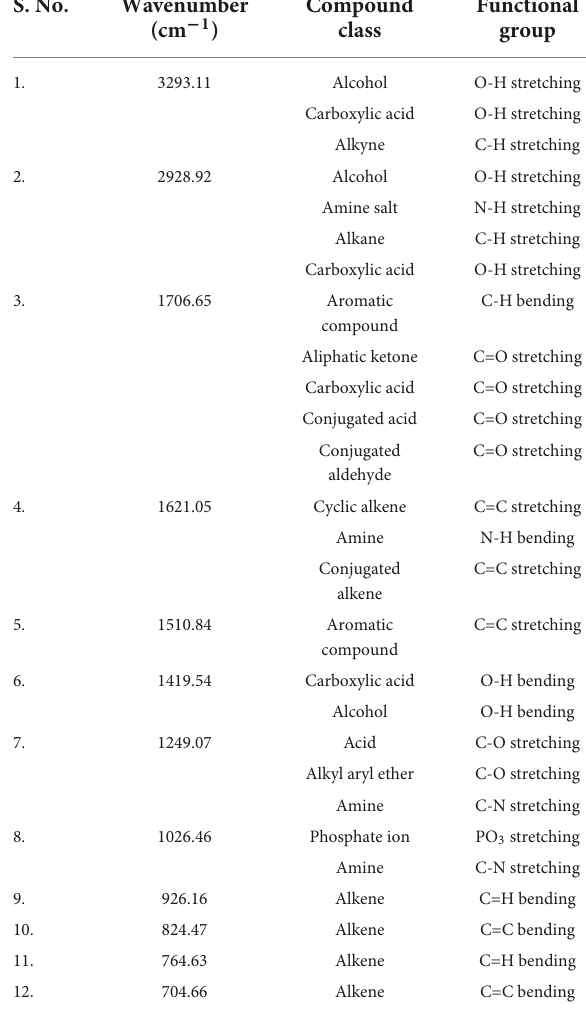
TABLE 3 Fourier transform infrared spectrometer (FTIR) peaks and their assigned functional groups of methanol root extract of Skimmia anquetilia .